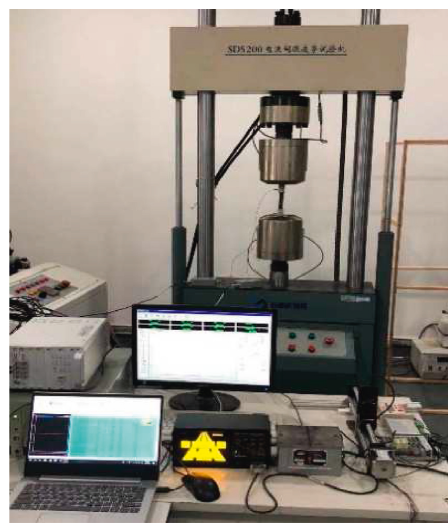
Figure 4: Experimental platform for magnetic-acoustic feature detection of fatigue damage